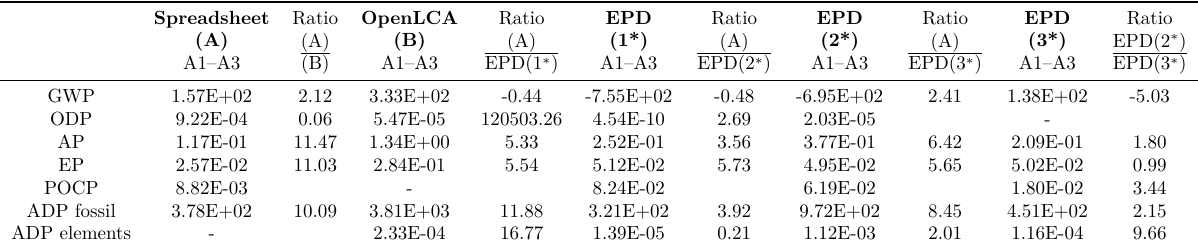
Table 2. Comparison of the results of the sum of stages A1-2-3 according to the spreadsheet of the GO MADERA project, in the OpenLCA software and with three EPDs declaring similar products and their corresponding